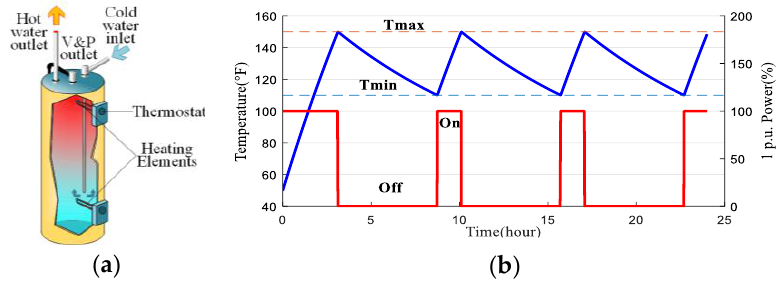
Figure 1. ( a ) Structure of electric water heater; and ( b ) traditional on/off control method